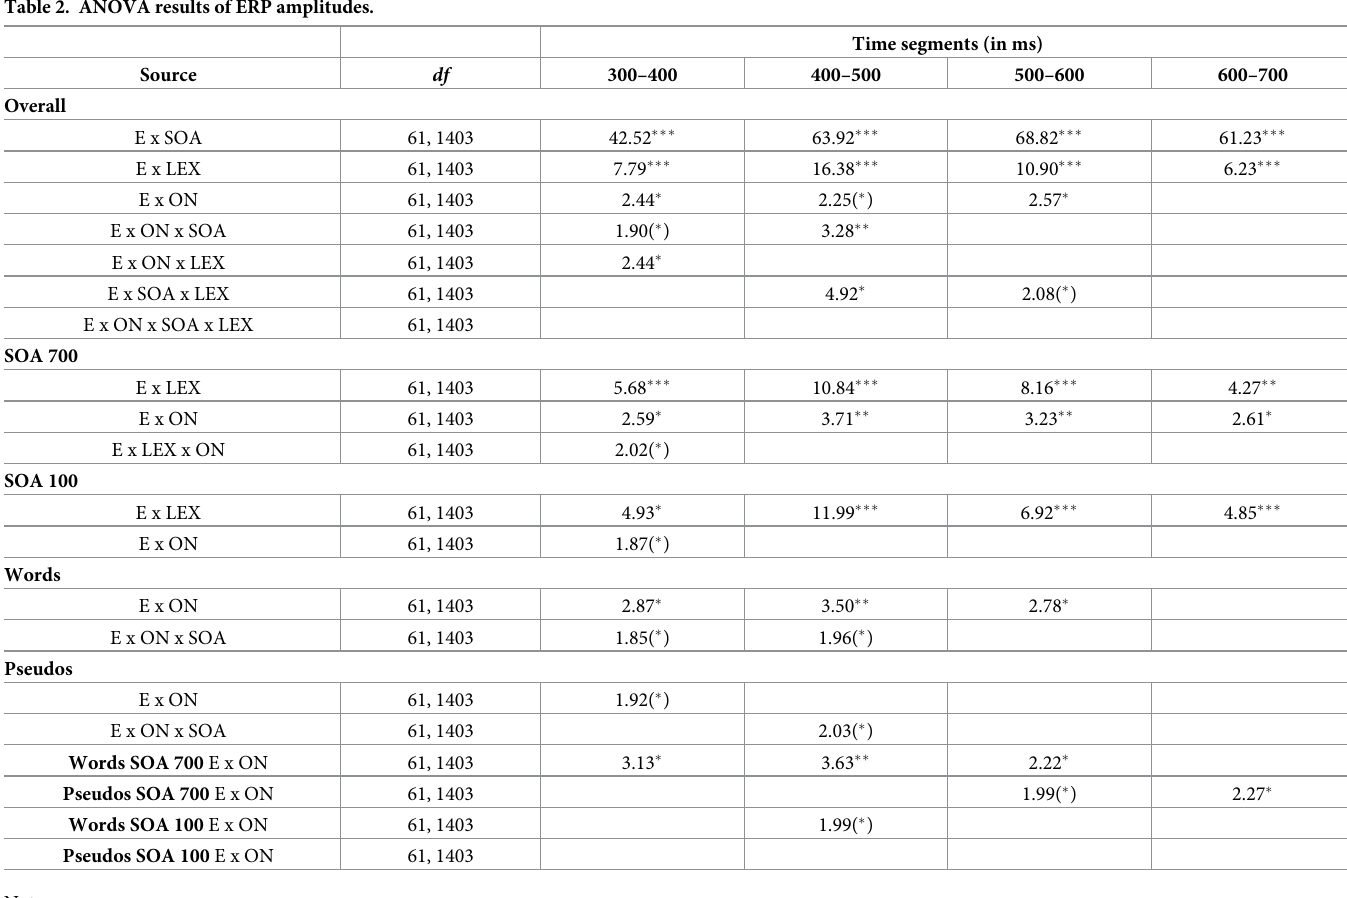
Table 2. ANOVA results of ERP